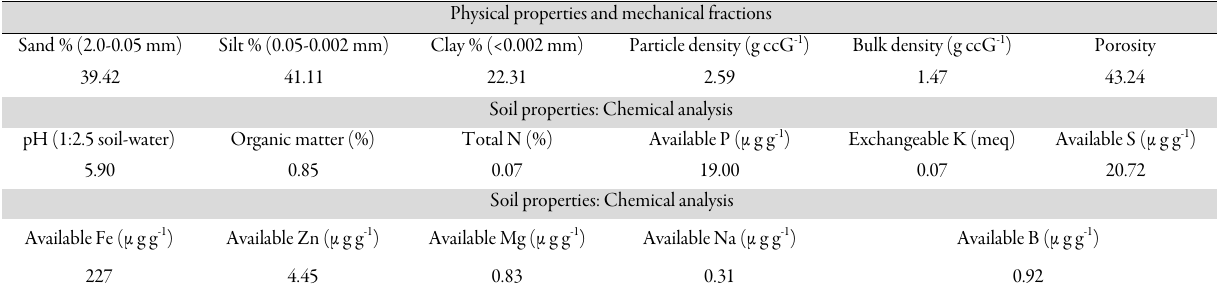
Table 1. Physical and chemical properties of the experimental soil as observed prior to experimentation Physical properties and mechanical